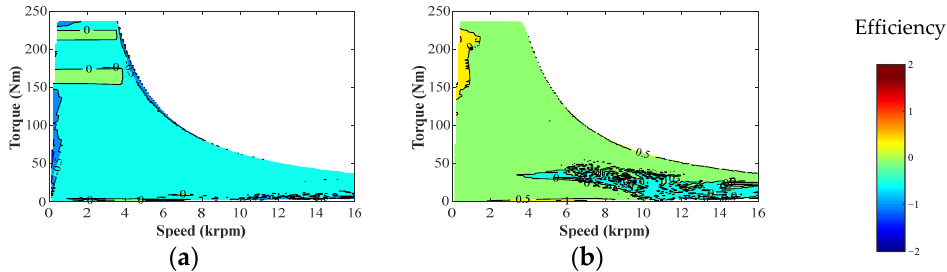
Figure 35. Differences between efficiency maps of DTP and ORG winding configurations: ( a ) DTP-SF; ( b ) DTP-DS.